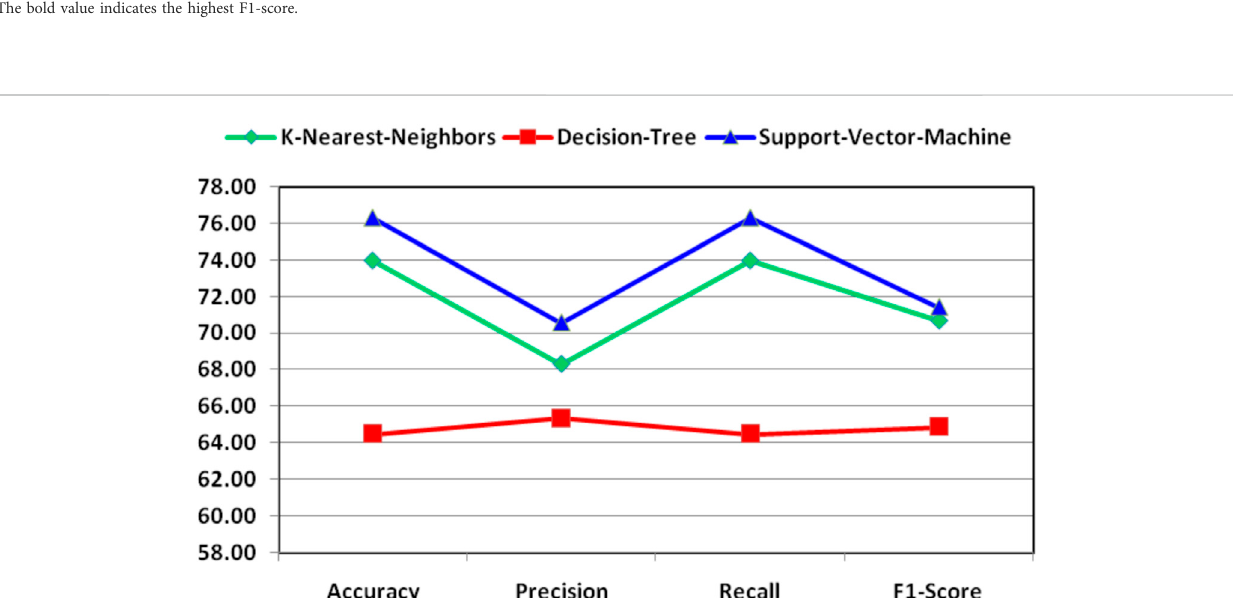
Support vector machine The bold value indicates the highest